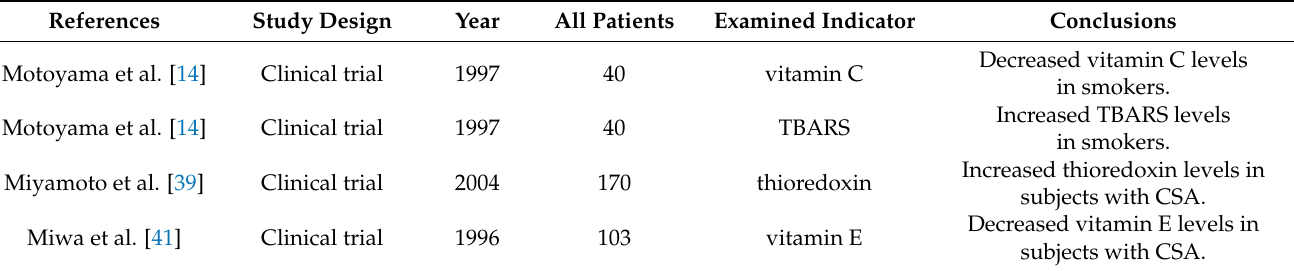
Table 1. Association between particular indicators and risk of